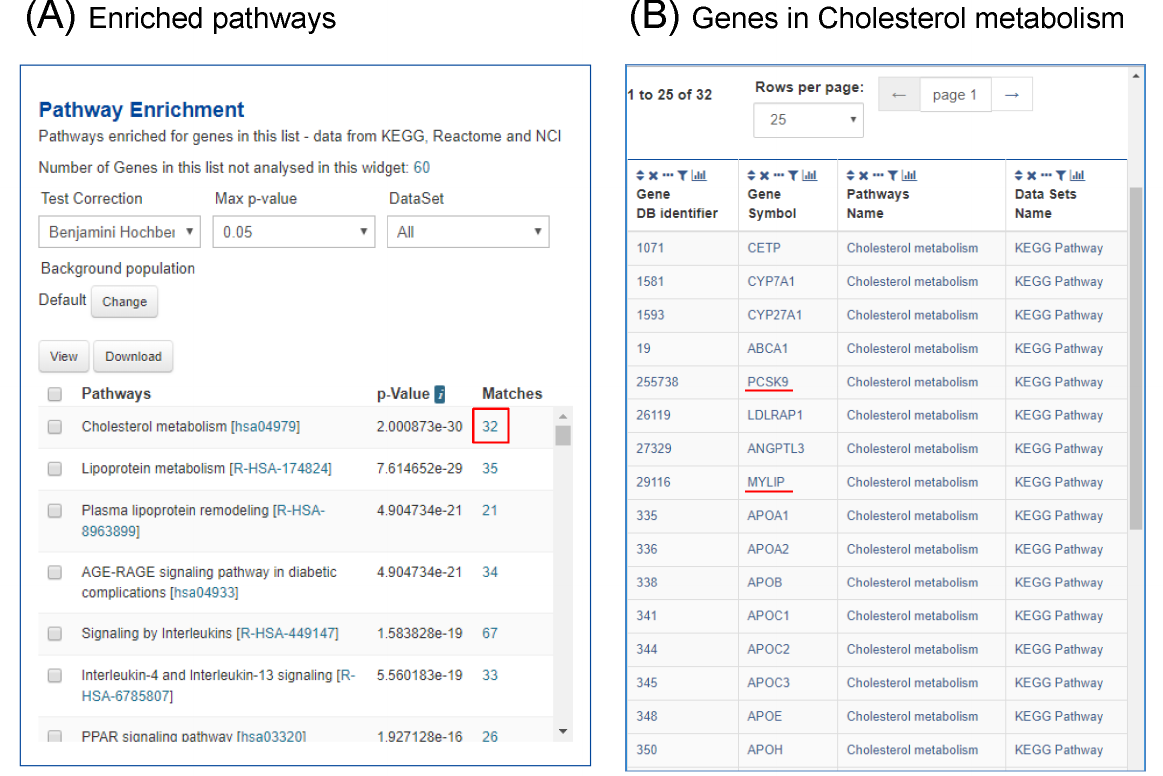
Figure 6. An example of pathway enrichment analysis. ( A ) Result of pathway enrichment analysis of the 510 human genes, which were described in Figure 5A. ( B ) Genes overlapped between the 510 human genes and those included in “Cholesterol metabolism”